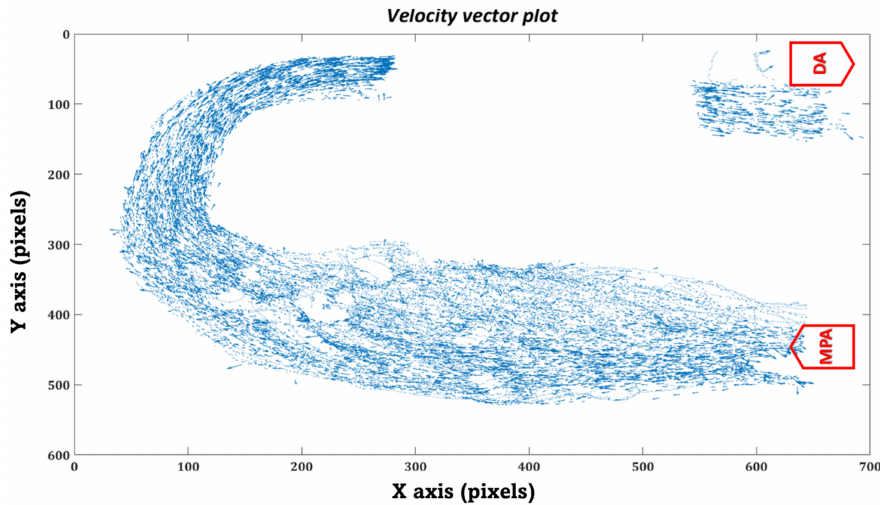
Figure 28. Velocity vector plot of the tracked particles in the MPA conduit for patient 1.